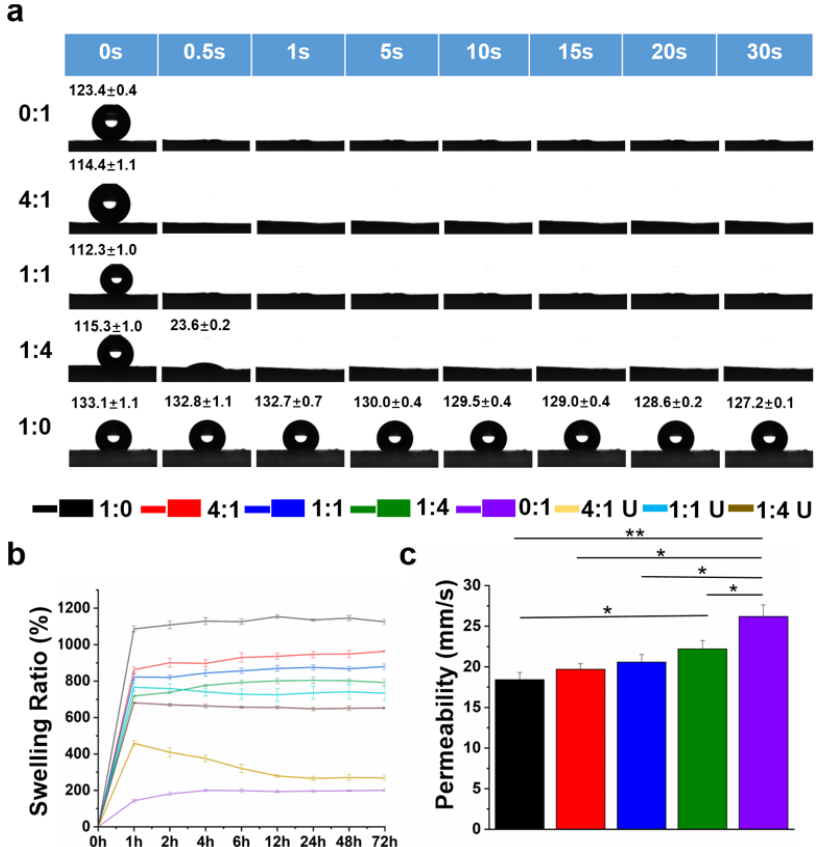
Figure 4. ( a ) Images of the water contact angle, ( b ) the swelling ratio, and ( c ) the air permeability of different MeGel/PLLA nanofiber mats after UV crosslinking (MeGel/PLLA = 1:0, 4:1, 1:1, 1:4, and 0:1) (n = 5; *p < 0.05, **p < 0. 01). The 4:1 U, 1:1 U, and 1:4 U in (b) stand for the swelling ratio of un ‐ crosslinked nanofiber mats with the MeGel/PLLA = 4:1, 1:1, and 1:4,